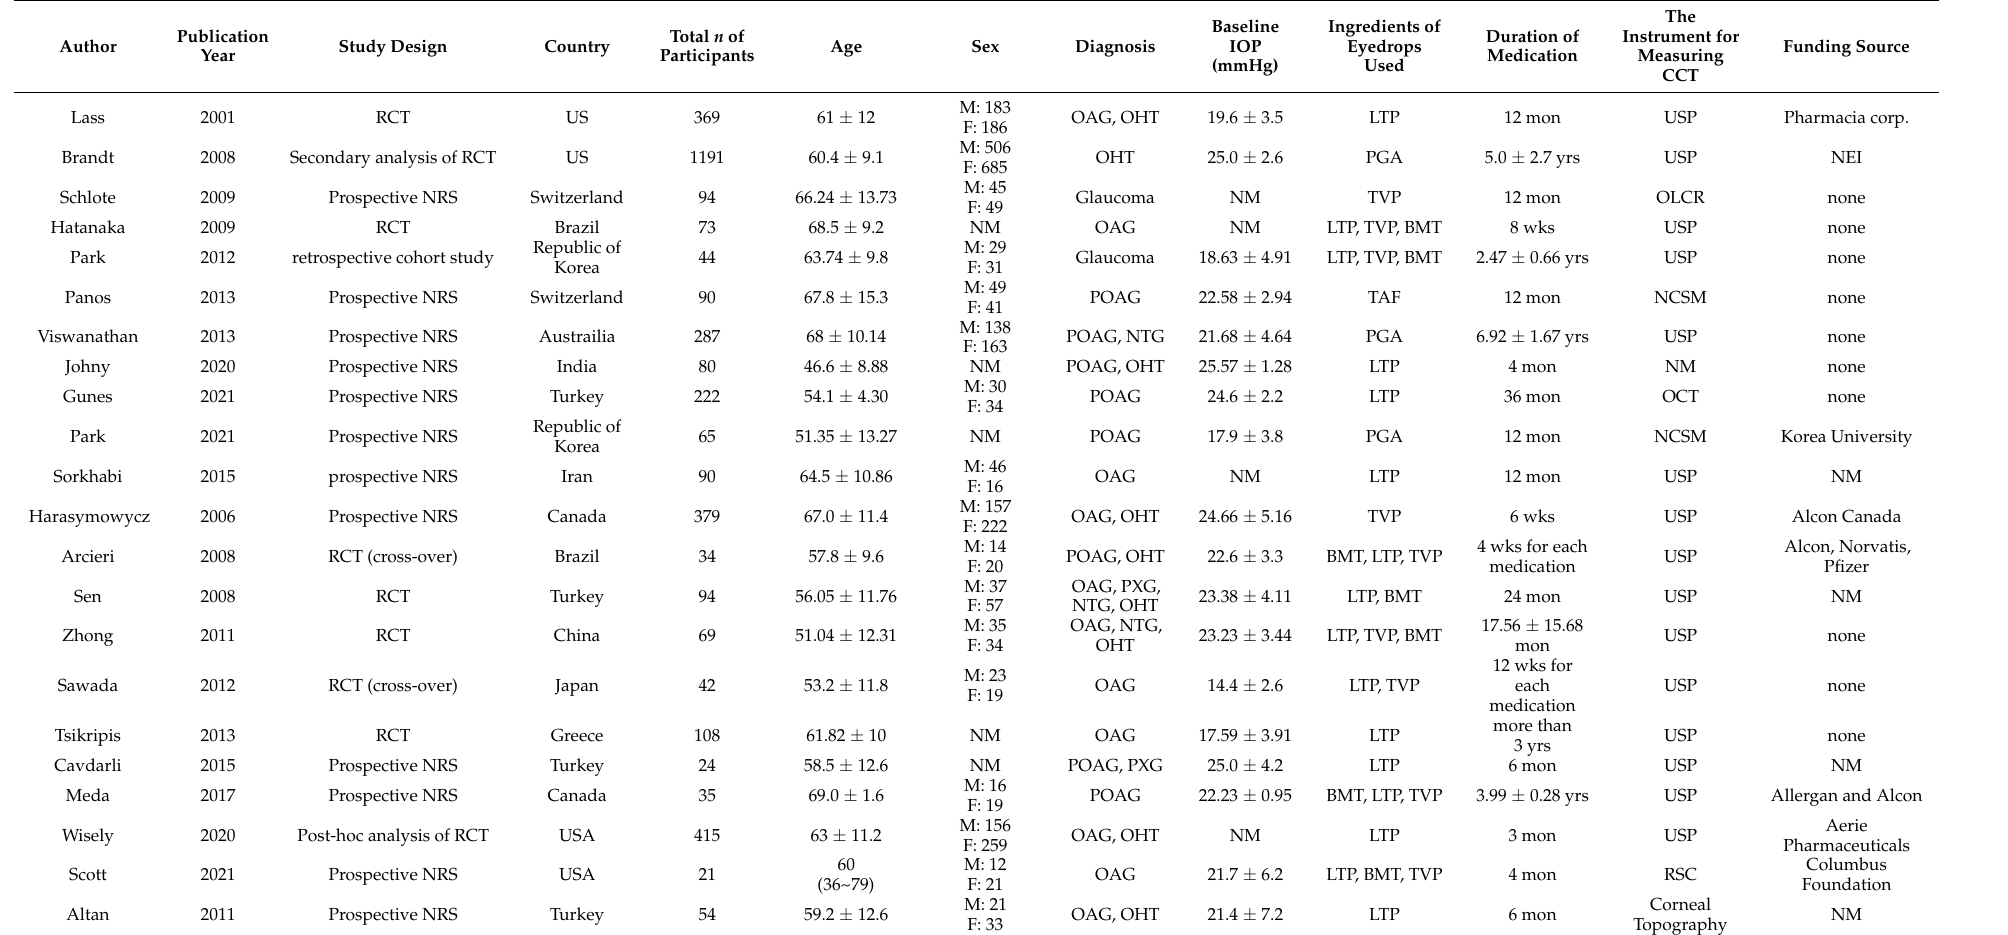
Table 1. Characteristics of the selected 22 prospective